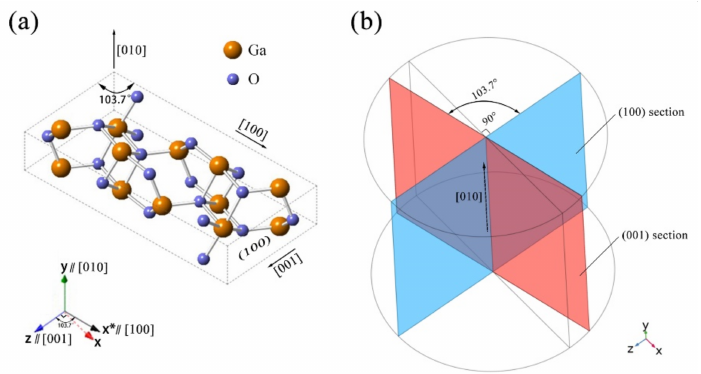
Figure 7. ( a ) Unit cell of β -Ga 2 O 3 in standard coordinate system. ( b ) Schematic diagram of two cross sections in a cylindrical